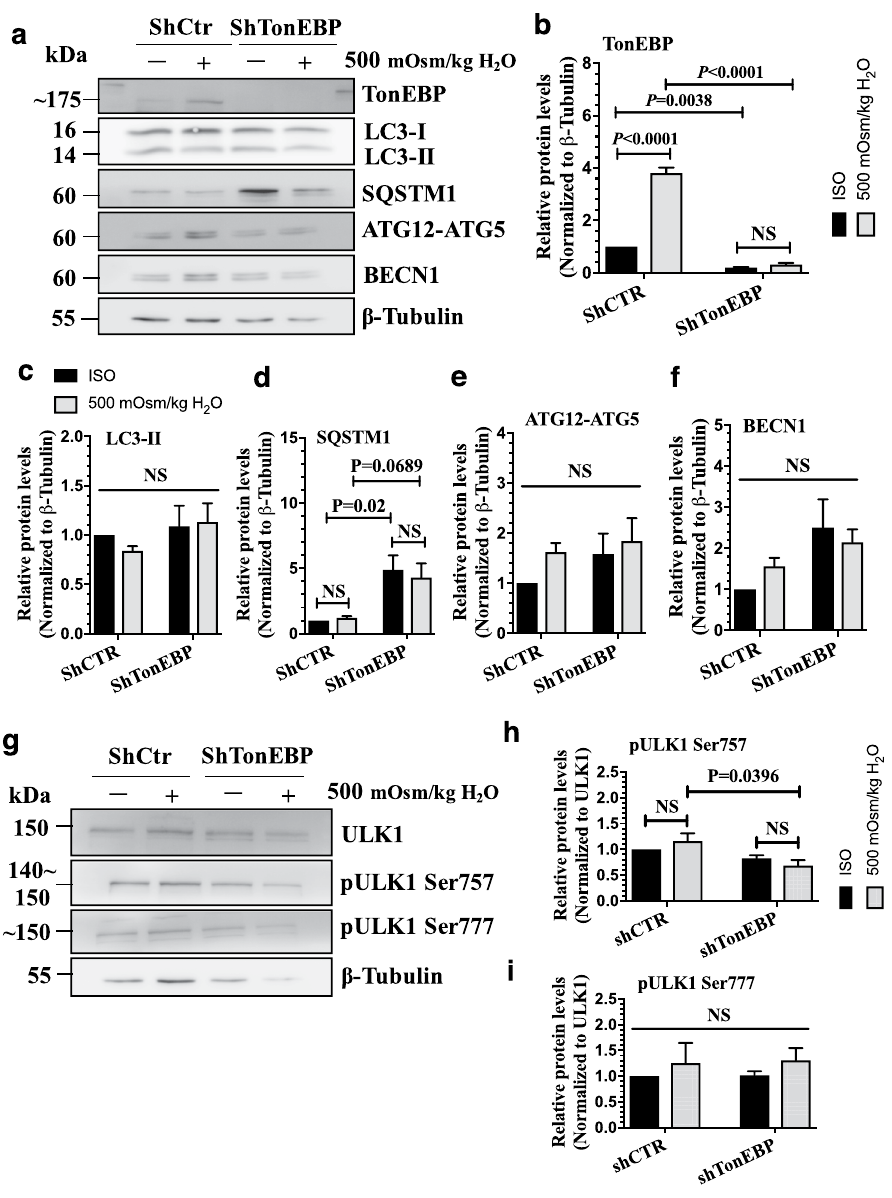
Figure 1. TonEBP does not control autophagy in NP cells. ( a ) Western blot analysis of NP cells transduced with a lentivirus expressing either control shRNA or shTonEBP plasmid showed that TonEBP silencing did not affect the levels of LC3-II, ATG12-ATG5, and BECN1. The levels of SQSTM1 increased with TonEBP silencing. ( b – f ) Densitometric analyses of multiple Western blots shown in ( a ). ( g ) Western blot analysis of ULK1 activation status showed that the levels of pULK1 Ser757 was slightly lower, while that of pULK1 Ser777 remained unaffected after TonEBP knockdown under hyperosmotic conditions. ( h , i ) Densitometric analyses of multiple western blots shown in ( g ). Bars represent mean ± SEM (n = 4). Two-way ANOVA with Tukey’s multiple comparisons test was used to determine statistical significance. NS, non-significant. Western blot images were cropped and acquired under same experimental conditions. See Supplementary Fig. S1 for examples of uncropped